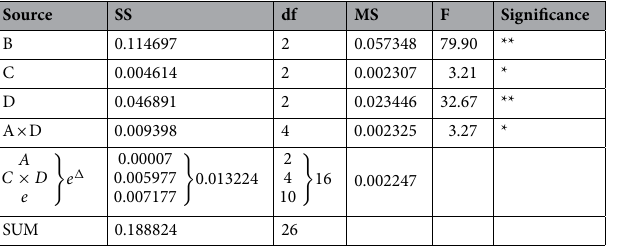
Table 4. Variance analysis. F checks the critical value in the table (critical value of F -test): F 0.1 (2,10) = 2.92;